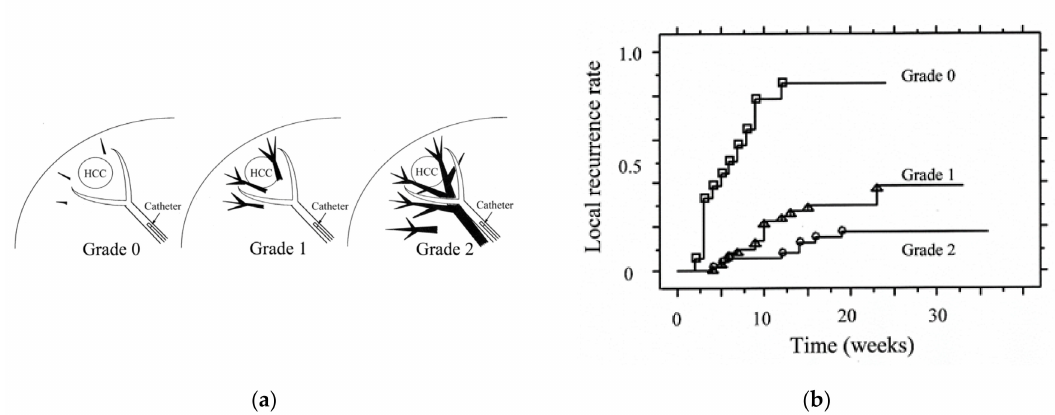
Figure 4. Classification of grades of portal vein visualization with iodized oil and relationship between local tumor recurrence. ( a ) Schematic representation of grades of portal vein visualization with iodized oil; ( b ) Graph shows the local recurrence rates calculated with the Kaplan-Meier method for each portal vein visualization group. The local recurrence rates for tumors in the grade 2 group were significantly lower than those for tumors in the grades 1 and 0 groups ( p = 0.0485 and p < 0.0001, respectively). The local recurrence rates for tumors in the grade 1 group were also significantly lower than those in the grade 0 group ( p < 0.0001). Reprinted with permission from Ref.